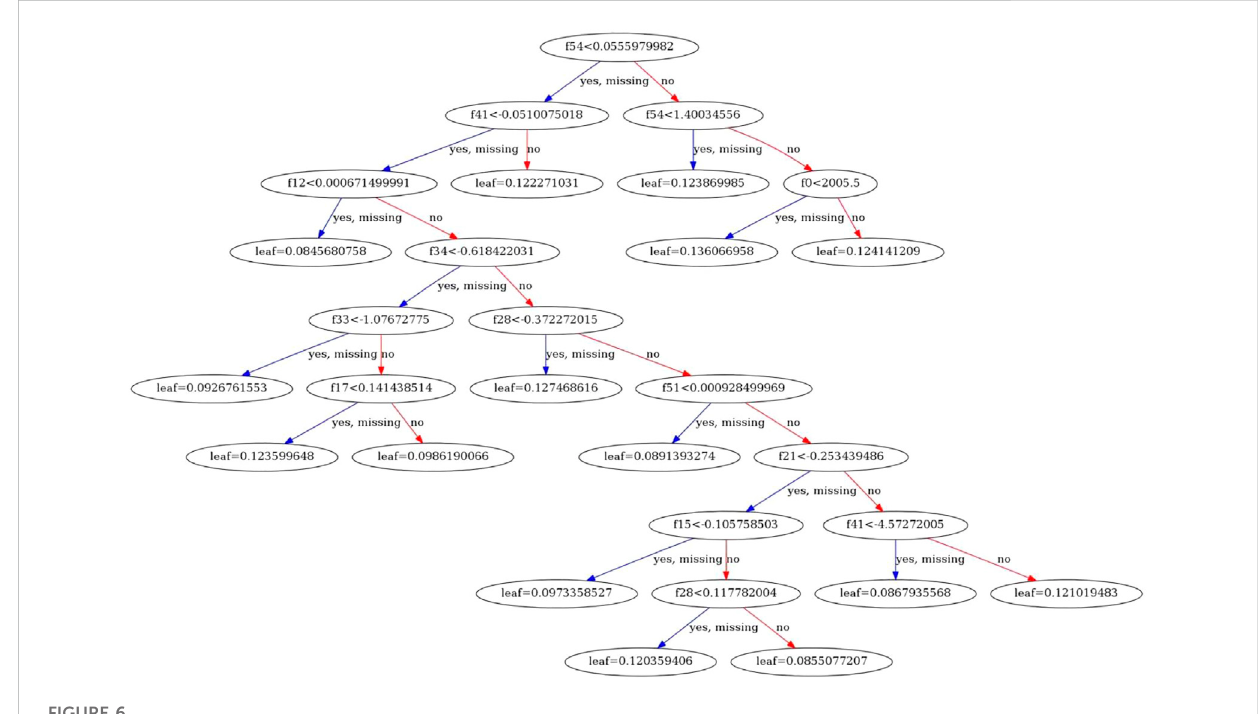
FIGURE 6 Schematic diagram of the XGBoost model.